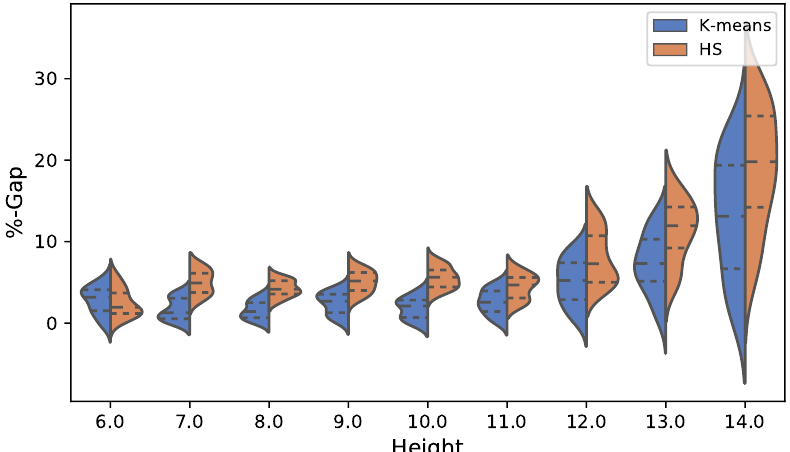
Figure 14. Violin plot comparison between k-means and HS results for CO 2